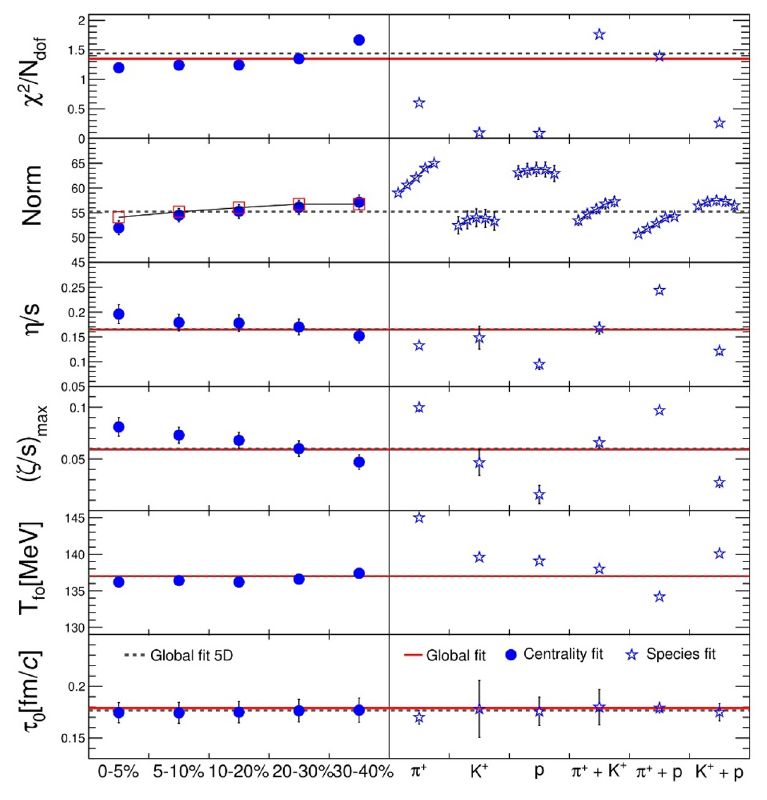
Figure 2 . Best (cid:12)t model parameters and corresponding (cid:31) 2 =N dof obtained when di(cid:11)erent centrality classes are (cid:12)tted separately (left side) and when the (cid:12)t is restricted to kaons or kaons and pions (right side). We use these variations to estimate uncertainties of the best (cid:12)t parameters as reported in table